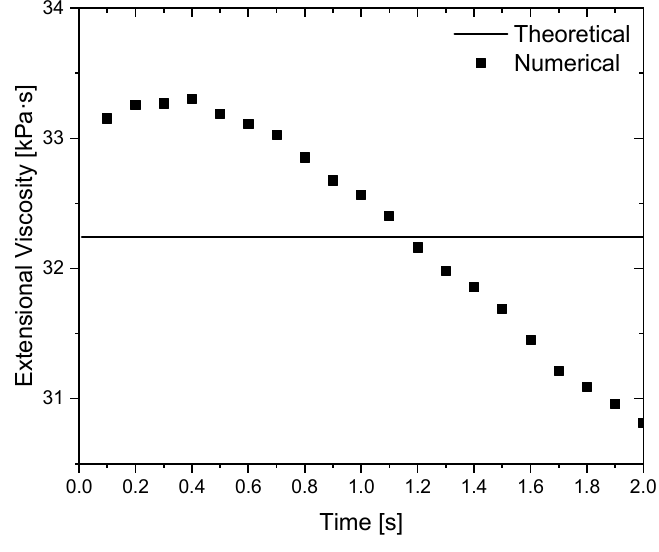
Figure 8. Extensional viscosity evolution: theoretical and numerical results.